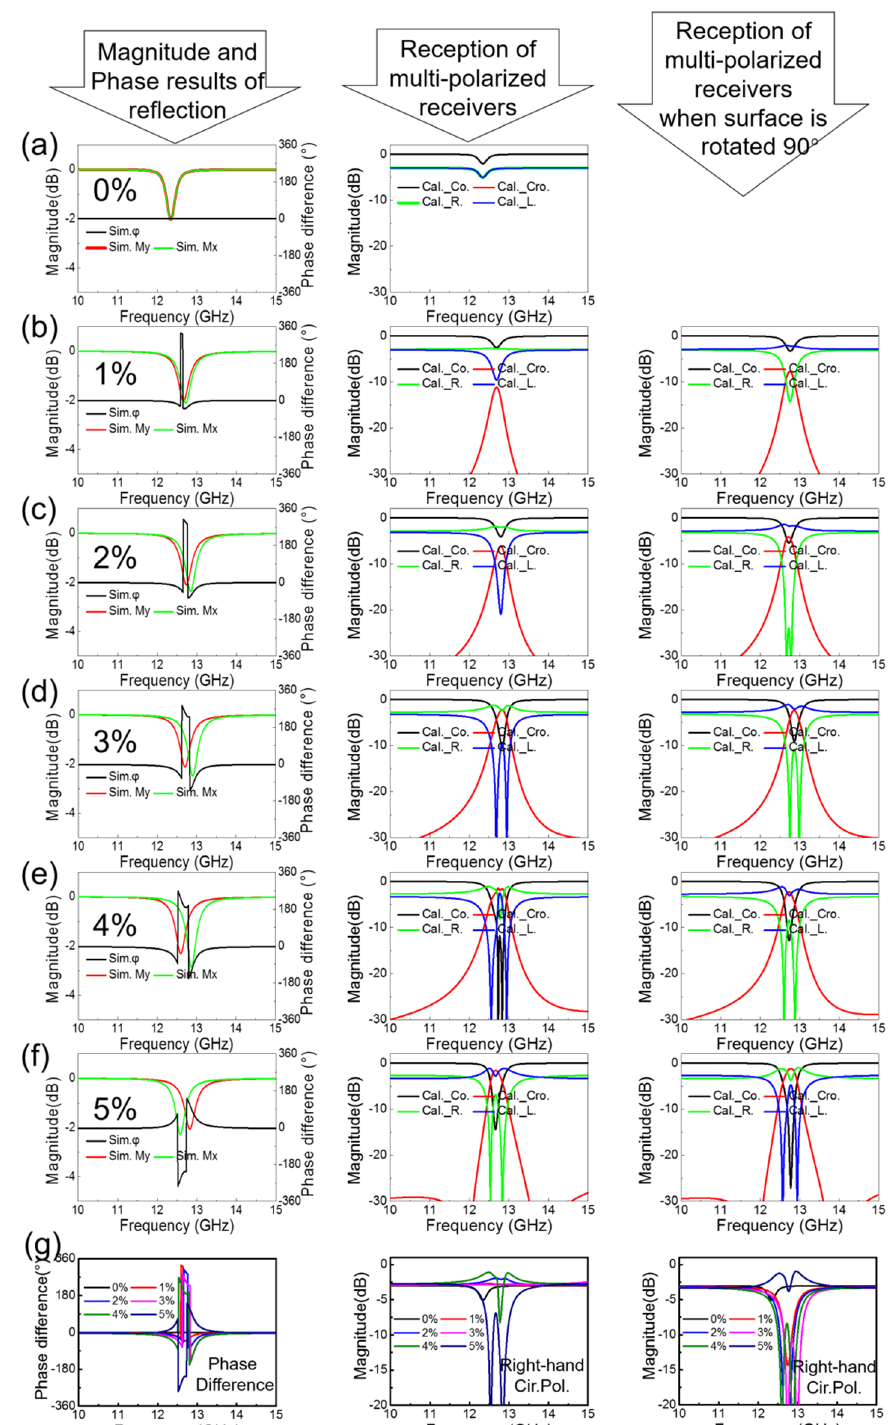
Figure 3. Simulation results for 0–5% strain states are shown in ( a – f ), respectively. The graphs in the first column show the results of the di ff erence between the reflective phases along the y and x axes and the magnitude of the reflective components along the y and x axes. The multi-polarized reception results for the deformations along the y and x axes are depicted in the graphs presented in the second and third columns, respectively. In ( g ), comparisons of phase di ff erence, right-hand circular-polarized reception are